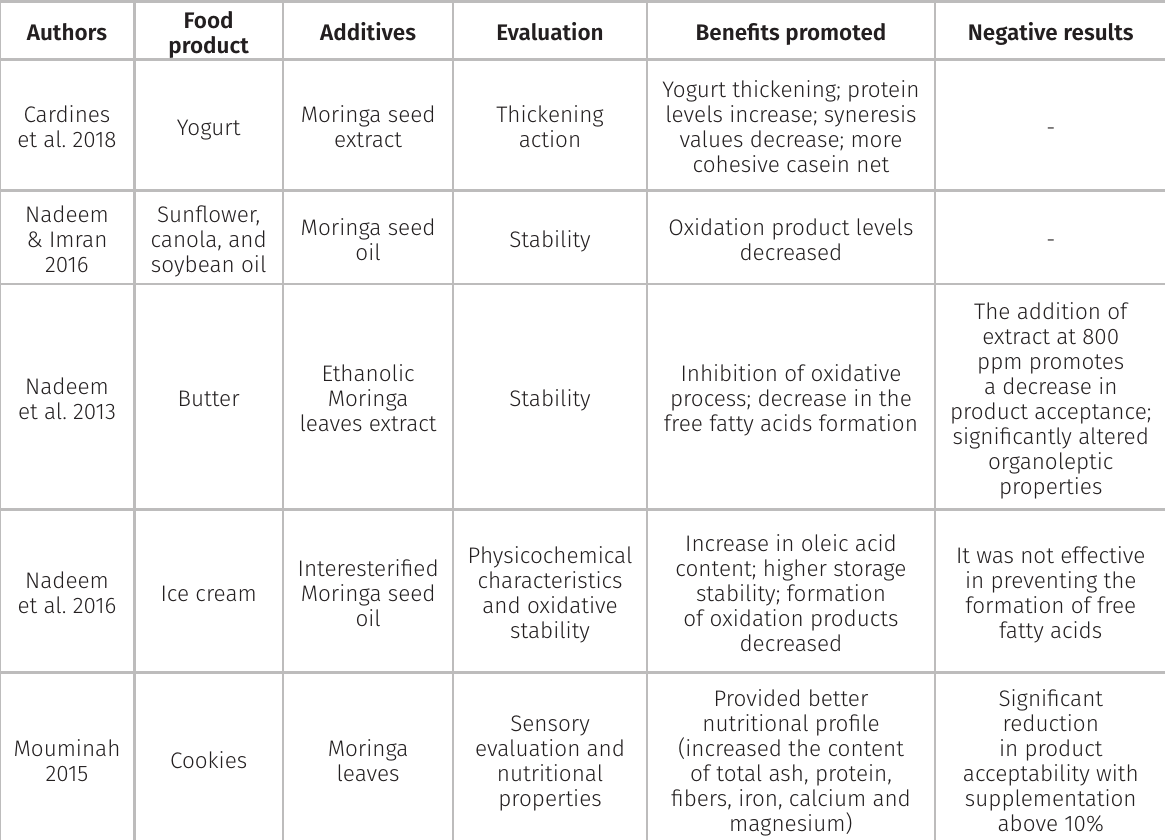
Table IV. Biochemical aspects in foods fortified with Moringa oleifera